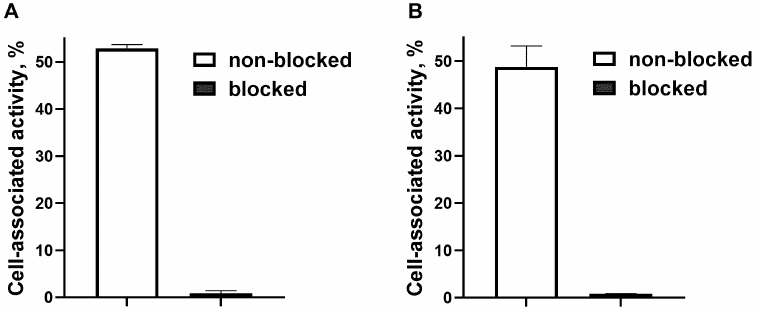
Figure 1. In vitro binding specificity of 188 Re-ZHER2:41071 to HER2-expressing SKOV-3 ( A ) and SKBR-3 ( B ) cells. For pre-saturation of HER2, a 500-fold molar excess of non-radiolabeled polypeptide was added. The data are presented as an average ( n = 3) value ±